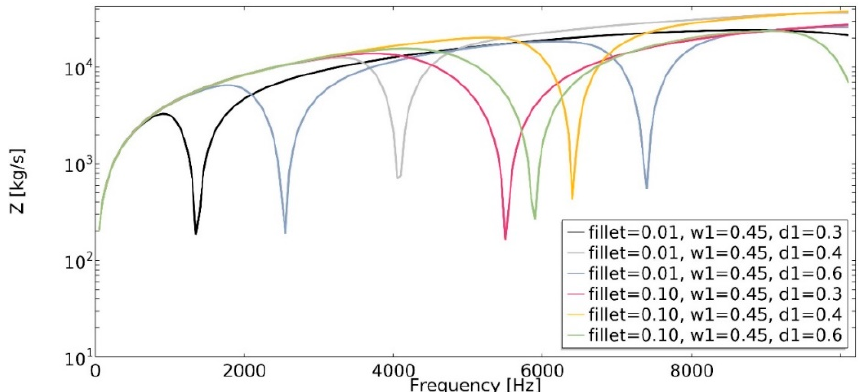
Figure 21. The influence of fillet radius on the value of mechanical impedance in the frequency range of 1–10,100 Hz.